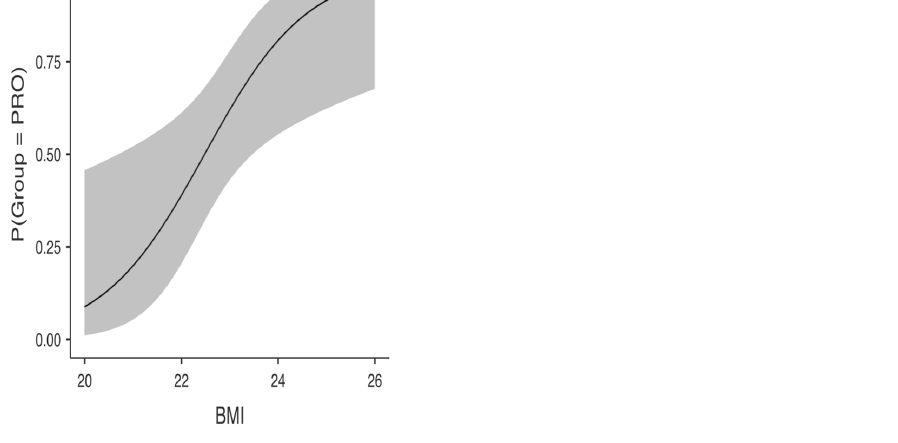
Figure 2. U19 body mass index (BMI) probability to become professionals (PRO). Table 4. Prediction Classification and Predictive Measures.